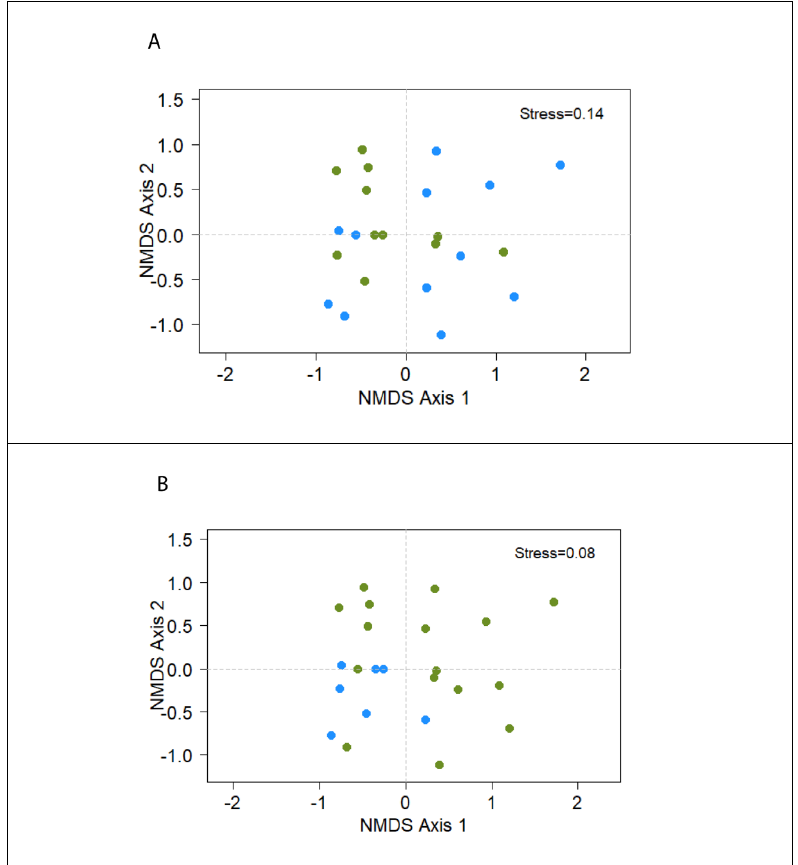
Figure 4. A . Nonmetric multidimensional scaling (NMDS) plot of species composition and farms. Blue dots represent water samples and green dots represent soil samples. B . Nonmetric multidi- mensional scaling plot of species composition and substrate. Blue dots represent water samples and green dots represent soil samples.